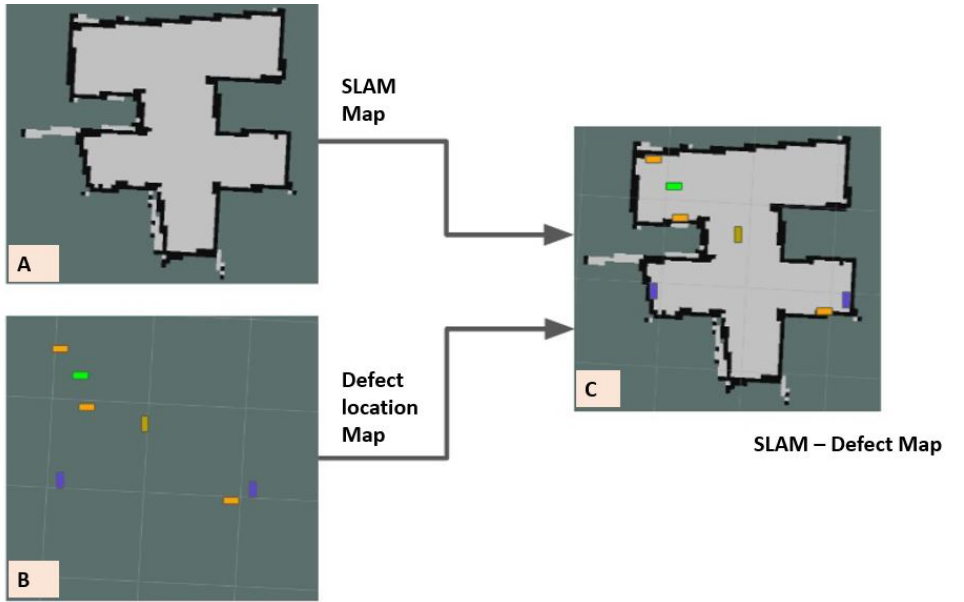
Figure 20. ( A ) SLAM Map; ( B ) Defect location Map; ( C ) SLAM-Defect Map. As in offline tests, Faster RCNN Inception-ResNet-v2 and Faster RCNN ResNet101 detect better than Faster RCNN ResNet50. The model detection accuracy for Faster RCNN ResNet50, Faster RCNN ResNet101, and Faster RCNN Inception-ResNet-v2 are 82%, 87%, and 89%, respectively. However, compared with offline tests, the model detection accuracy is relatively low due to the missed detection of